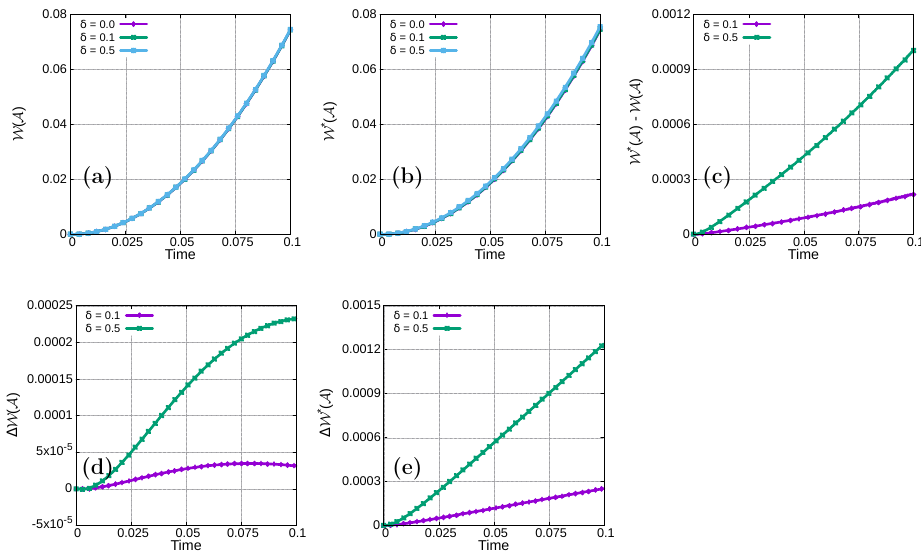
Figure 4. Profile of ( a ) W ( A ) , ( b ) W ∗ ( A ) , ( c ) W ∗ ( A ) − W ( A ) , ( d ) ∆ W ( A ) and ( e ) ∆ W ∗ ( A ) in an L-shaped cantilever during the loading